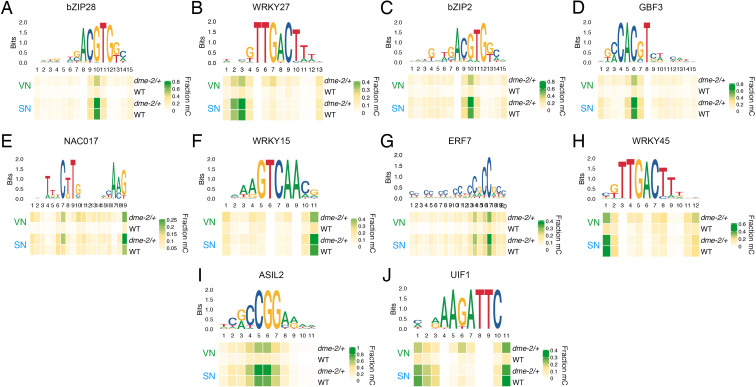
DEMETER (DME) demethylates predicted TF binding sites specifically in the VN.(A–J) DNA methylation level at predicted binding sites within DME-targeted accessible chromatin regions (ACRs) for the remaining 10 methylation-sensitive TFs shown in Figure 4E – bZIP28 (A), WRKY27 (B), bZIP2 (C), GBF3 (D), NAC017 (E), WRKY15 (F), ERF7 (G), WRKY45 (H), ASIL2 (I), and UIF1 (J). Each heatmap summarises the proportion of methylated cytosines over the predicted binding sites in VN and SN of wild-type (WT) and dme-2/+ pollen. Single base pair positions are indicated by the corresponding position frequency matrix logo plotted above each heatmap.